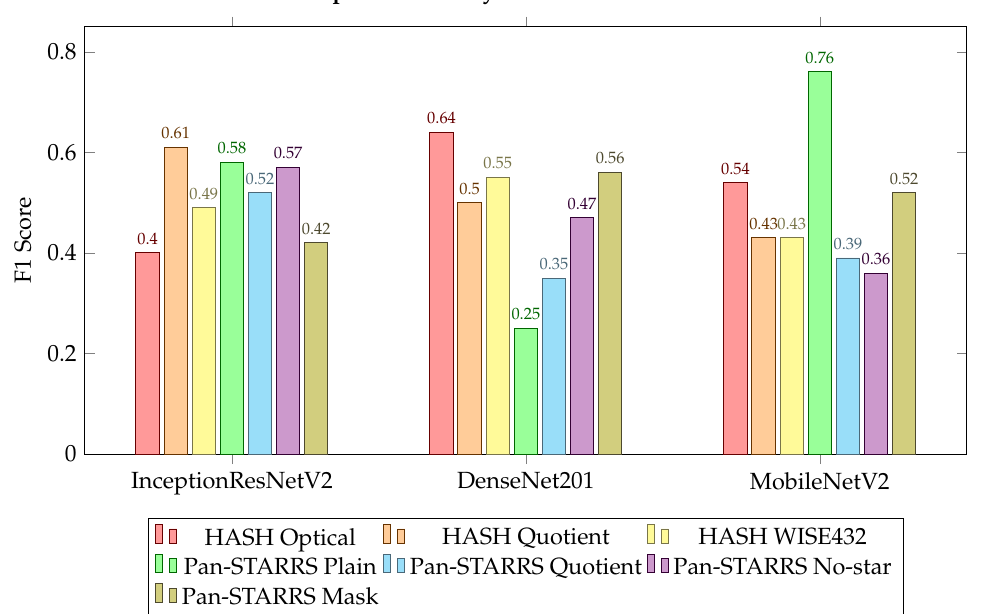
Figure 11. Bipolar planetary nebulae morphology classification F1 score using the Test set from HASH DB and